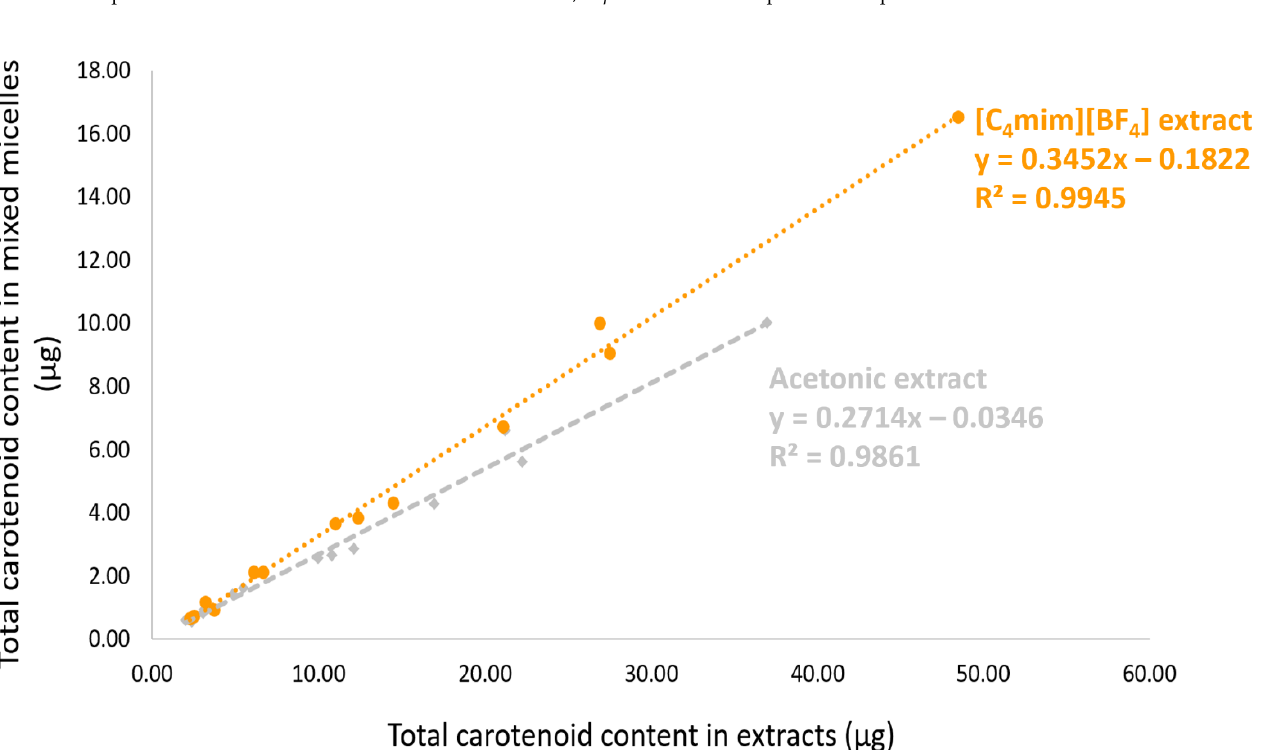
* Data are the mean ± standard deviation of three samples; a The percentage value is related to the initial mass of the emulsion; # p < 0.05 when compared with the BCT of the acetone carotenoid extract; ## p < 0.05 when compared with uptake of the acetone carotenoid extract.